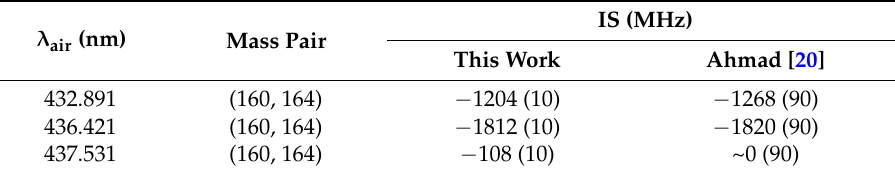
Table 5. Comparison of IS measurements with previous work.